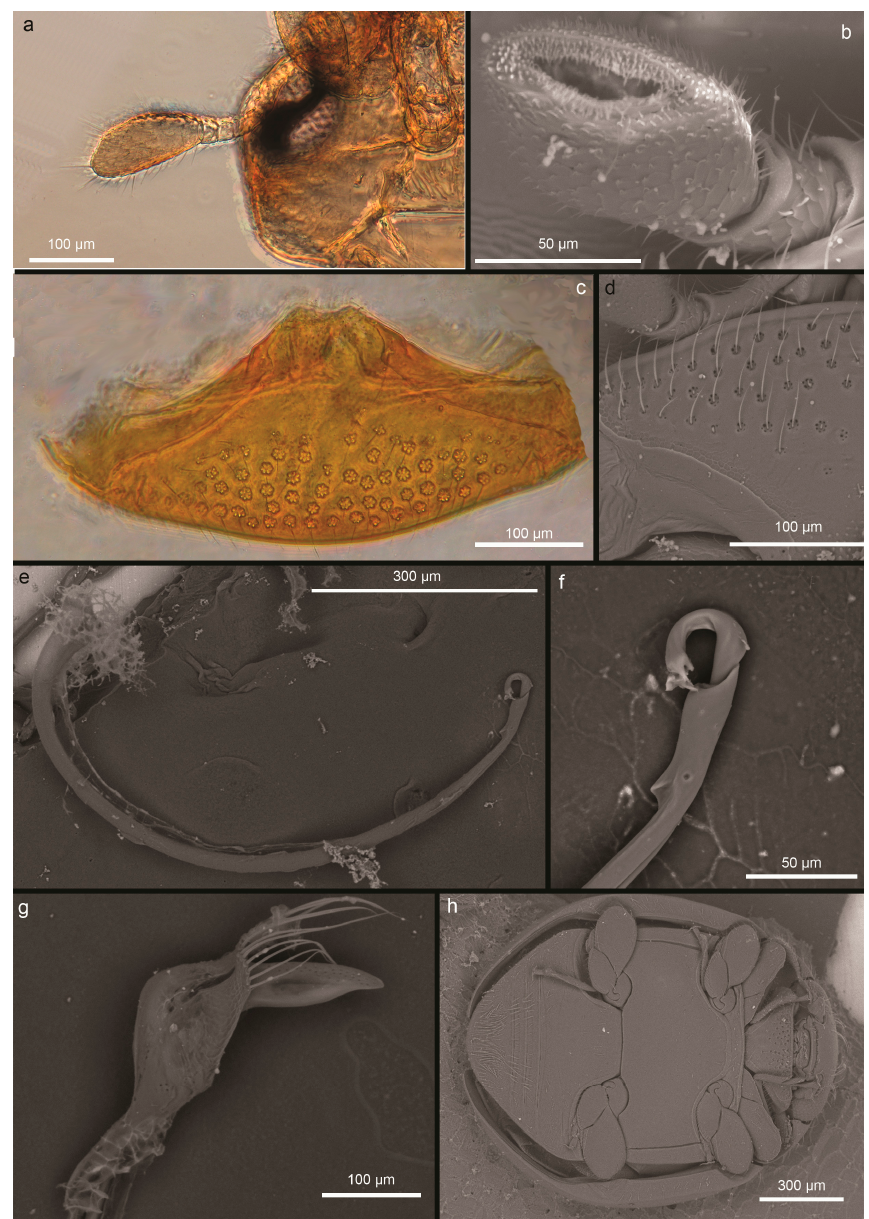
Figure 3. Delphastus catalinae morphological characters. ( a ) antenna, ( b ) apical segment of maxillary palp, ( c ) prosternum, ( d ) particular of the setae encircled by loculi, ( e ) sipho, ( f ) tip of the sipho, ( g ) median lobe of parameres, and ( h ) body (ventral side).